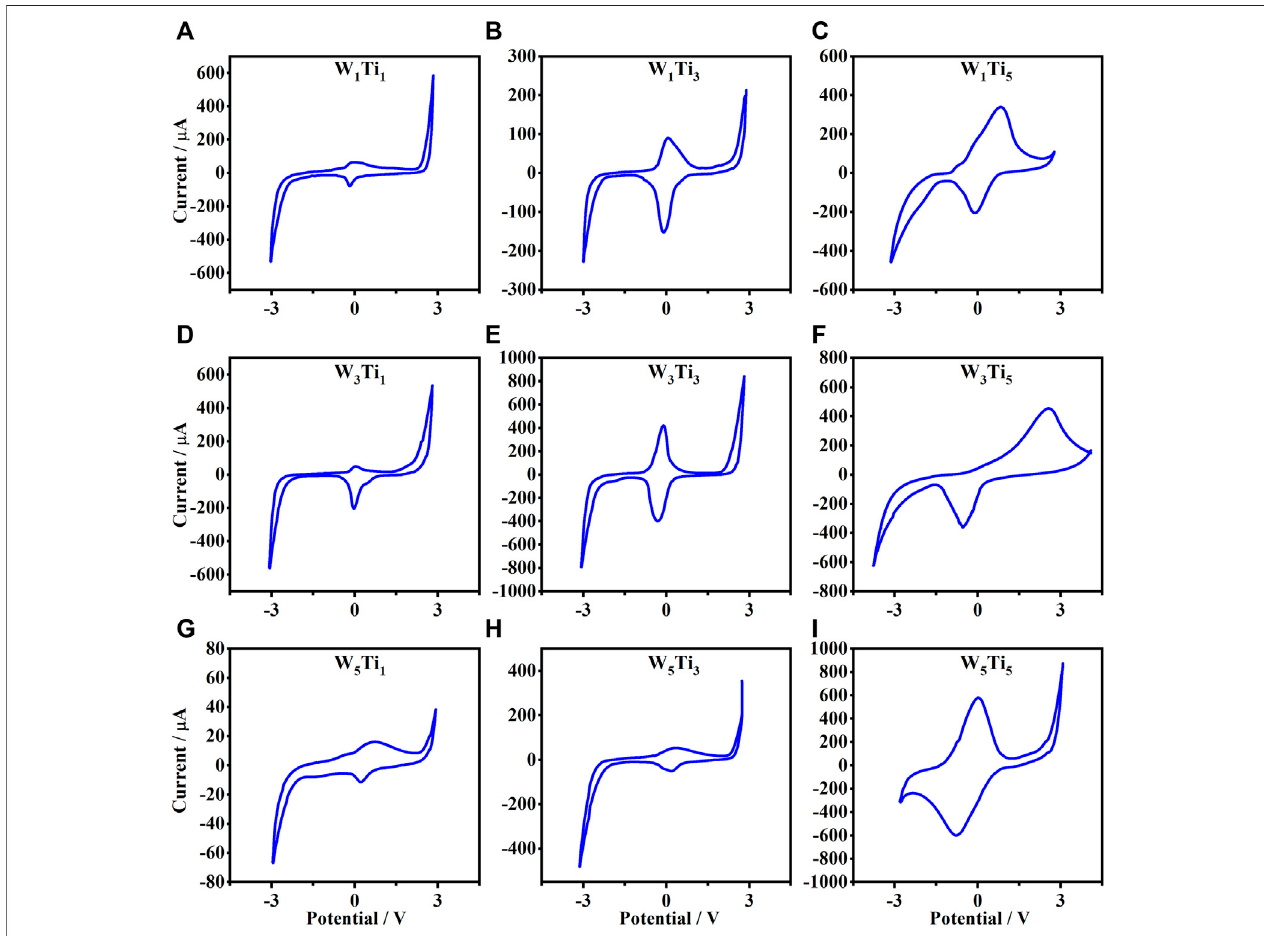
FIGURE 3 | Cyclic voltammetry from − 3.5 to 3.5 V (scan rate of 50 mV/s) of the nine following electrochromic devices: (A) W 1 Ti 1 , (B) W 1 Ti 3 , (C) W 1 Ti 5 , (D) W 3 Ti 1 , (E) W 3 Ti 3 , (F) W 3 Ti 5 , (G) W 5 Ti 1 , (H) W 5 Ti 3 and (I) W 5 Ti 5 . (W x Ti y where W and Ti indicate the WO 3 and TiO 2 electrodes, respectively and the subscripts x and y indicate their annealing temperature expressed in hundreds,